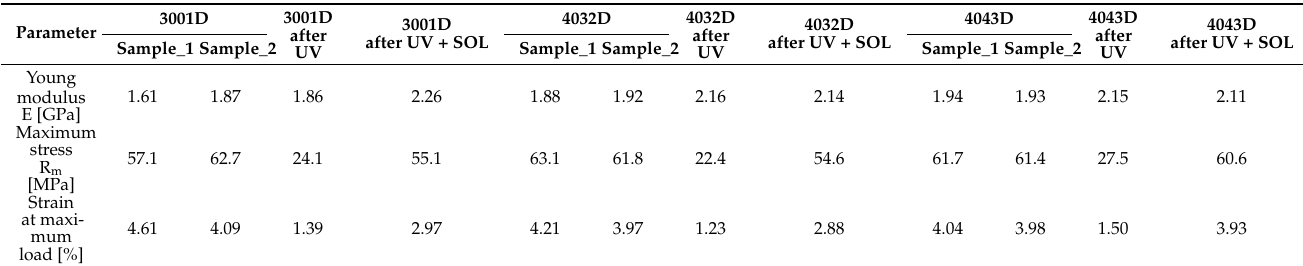
Figure 9a,b present the tensile characteristics for sample 4032D admixed with GNP.